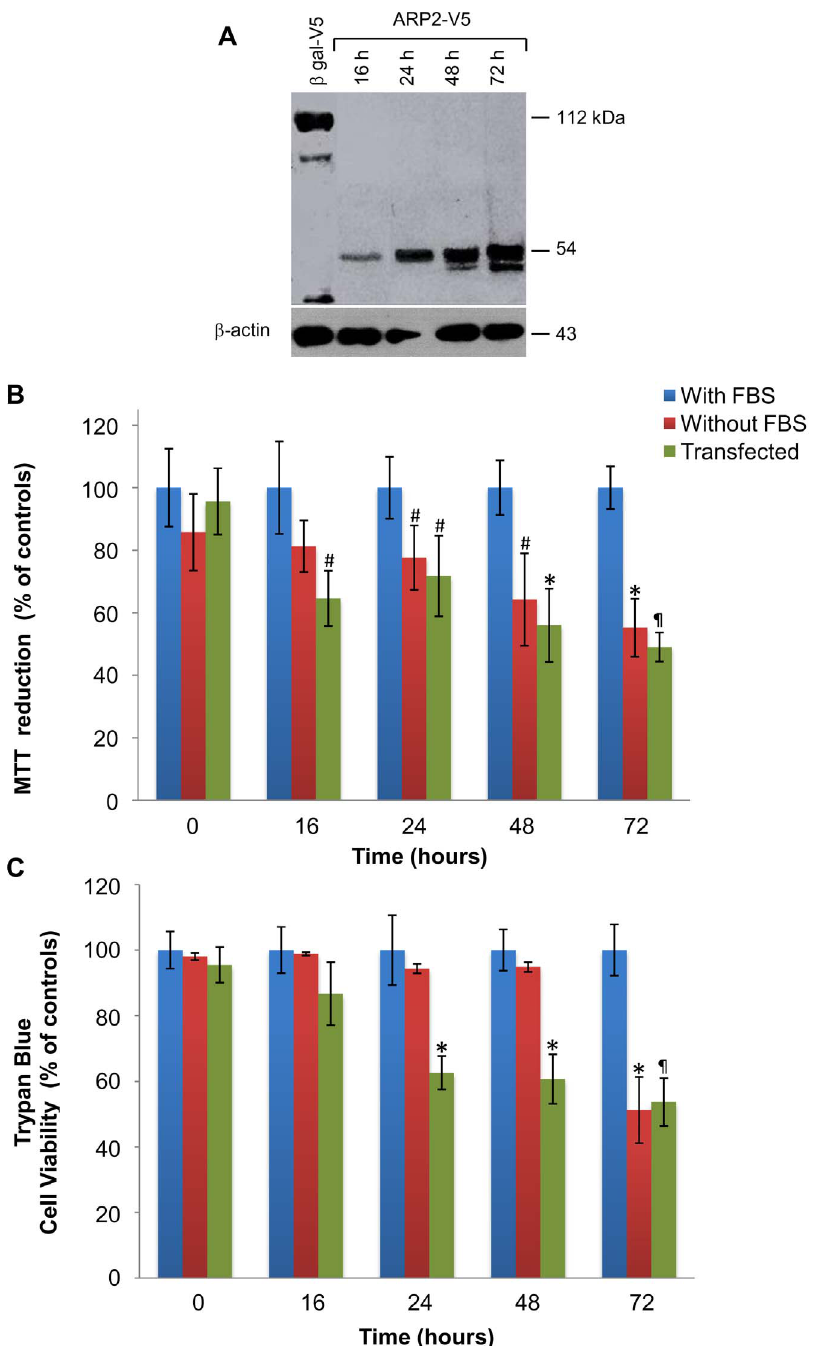
Figure 2. ARP2 expression induces apoptosis in CHO cells. ( A ) Western blots detected expression of b -gal-V5 (112 kDa) and ARP2-V5 (54 kDa) in total cell lysates. ( B ) Normalized cell viability% of controls was assessed using MTT assays with 2 6 10 4 cells cultured in the absence of serum or transfected with arp2 cDNA. Viability of these two treatment groups were assayed at 16, 24, 48, and 72 h timepoints. ( C ) Normalized cell viability% of controls was assessed using a trypan blue exclusion method. Cells were cultured in the absence of serum or transfected with arp2 cDNA and assayed at 16, 24, 48, and 72 h timepoints. Mean values are presented (n=3, X 6 S.E.M), # p , 0.05, * p , 0.01, " p , 0.001, compared to control groups. doi:10.1371/journal.pone.0086089.g002 540 nm using a bandpass filter. Laser operation was performed at and DIC images were visualized, processed, and converted to low power (97–99% attenuation) which substantially reduced TIFF formatted images using the FV10-ASW 6.1 software photobleaching and photodamage to specimens. DIC microscopy (Olympus). images were obtained using an Olympus IX81 microscope and a IX2-LWUCD capacitor with 10 6 and 40 6 objectives. Confocal